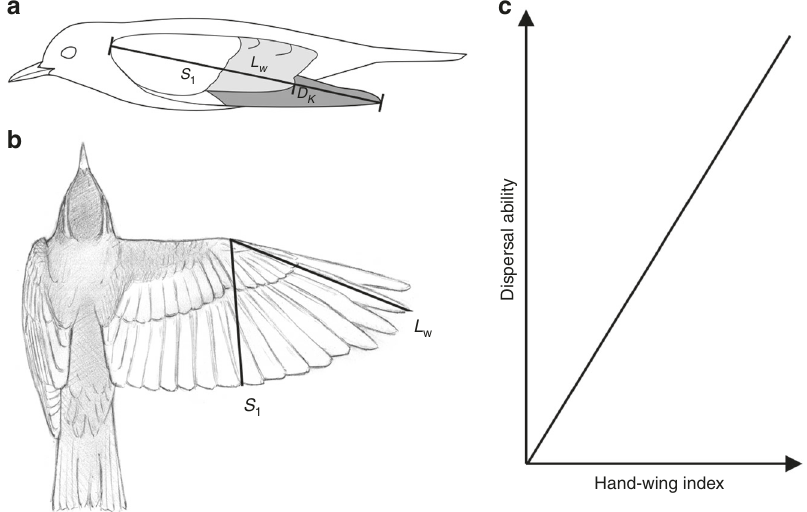
Fig. 1 Calculating the hand-wing index (HWI). a Diagram showing linear measurements used to calculate HWI taken on a standard museum study skin (secondary feathers shown in pale grey; primary feathers in dark grey). Wing length ( L w ) is the distance from carpal joint to the tip of the longest primary feather; secondary length ( S 1 ) is the distance from carpal joint to the tip of the fi rst secondary feather; Kipp ’ s distance ( D K ) is the difference between L w and S L S ’ s span and width, and hence to its aspect ratio. c Because it is correlated 1 . b Open wing of a passerine bird showing how w and 1 are related to the wing with the aspect ratio, HWI is in theory positively associated with fl ight ef fi ciency and key aspects of dispersal ability, including dispersal distance and gap- crossing